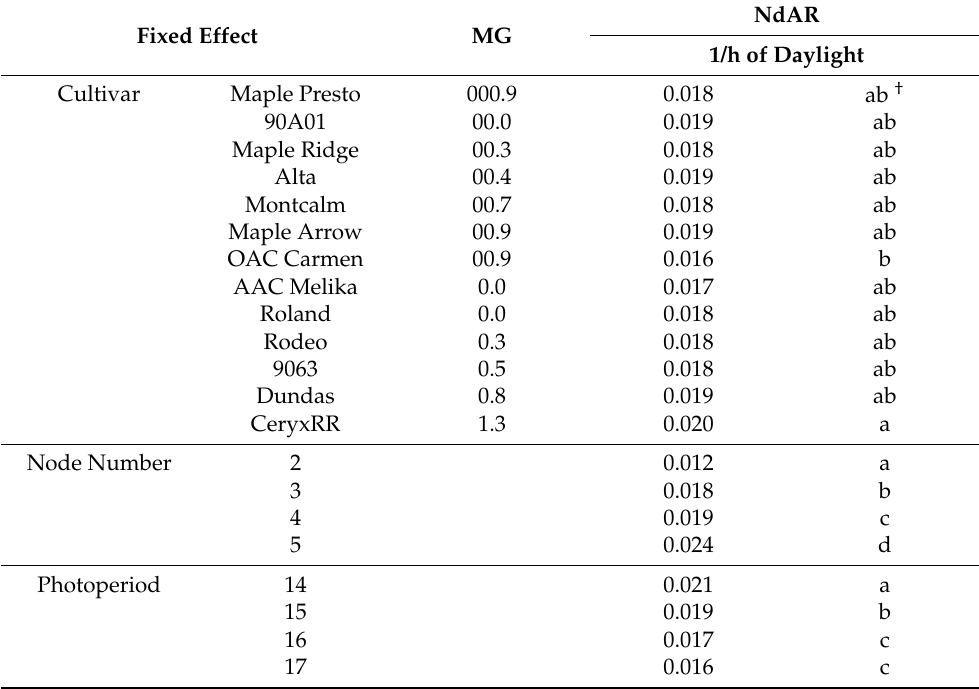
Table 2. The node appearance rate (NdAR) from the second to the fifth main stem node for cultivars and their corresponding maturity group (MG), main stem node number, and 14-, 15-, 16-, and 17-h photoperiod